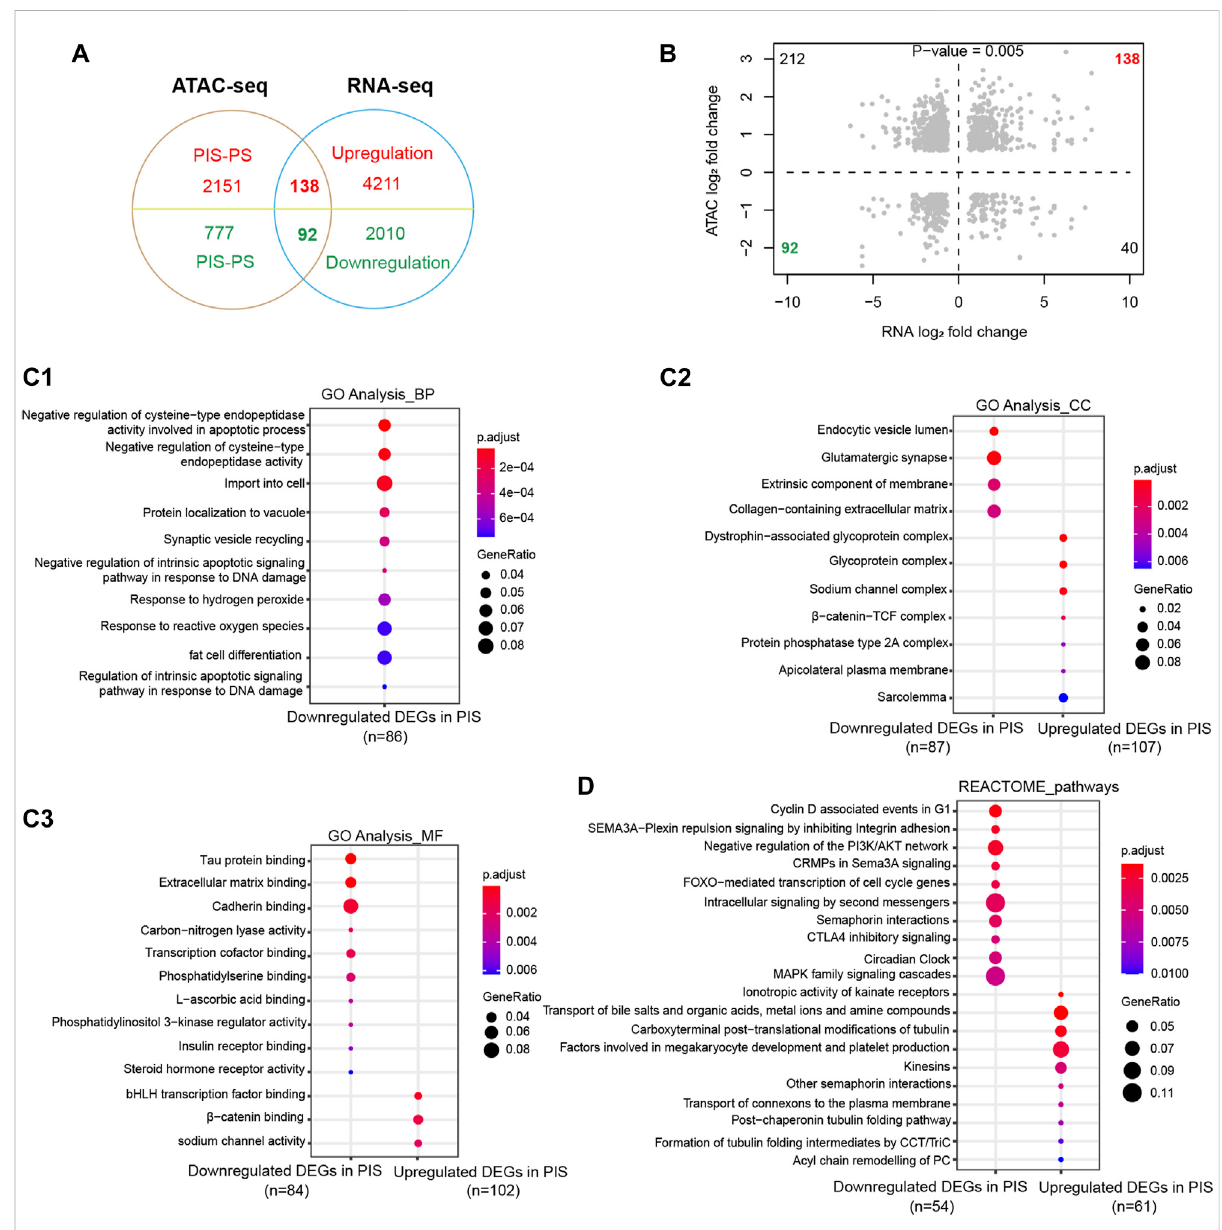
FIGURE 3 EnrichmentanalysisofDEGsintegratedbyATAC-SeqandRNA-Seq. (A) VenndiagramofDEGsinRNA-Seqwithdifferentialopeningandclosing peaks in ATAC-Seq. (B) Chromatin accessibility correlates signi fi cantly with the 230 overlapping DEGs (Pearson analysis, p = 0.005). Dashed lines delineate the setofDEGs inRNA-Seq (X-axis) anddifferential opening or closing peaksinATAC-Seq (Y-axis) betweenthePIS andPS groups.Shaded pointsintheupperrightquadrantandlowerleftquadrantde fi nethegenesshowingcongruentchromatinaccessibilityandgeneexpression. (C) GO annotation of the upregulated and downregulated DEGs in the PIS group compared to the PS group was performed based on ATAC-Seq and RNA-Seq integration, including BP ( C1 ), CC ( C2 ), and MF ( C3 ). The top ten clusters with adjusted p < 0.05 were shown. (D) REACTOME pathway annotation of the overlapping upregulated and downregulated DEGs in the PIS group by ATAC-Seq and RNA-Seq integration. The top ten enriched pathways with adjusted p < 0.05 were shown. Abbreviations: ATAC-Seq, assay for transposase-accessible chromatin sequencing; RNA-Seq, RNA sequencing;PIS,progestin insensitive; PS,progestinsensitive;DEGs, differentiallyexpressedgenes; GO,GeneOntology; BP,biologicalprocess; CC, cellular components; MF, molecular